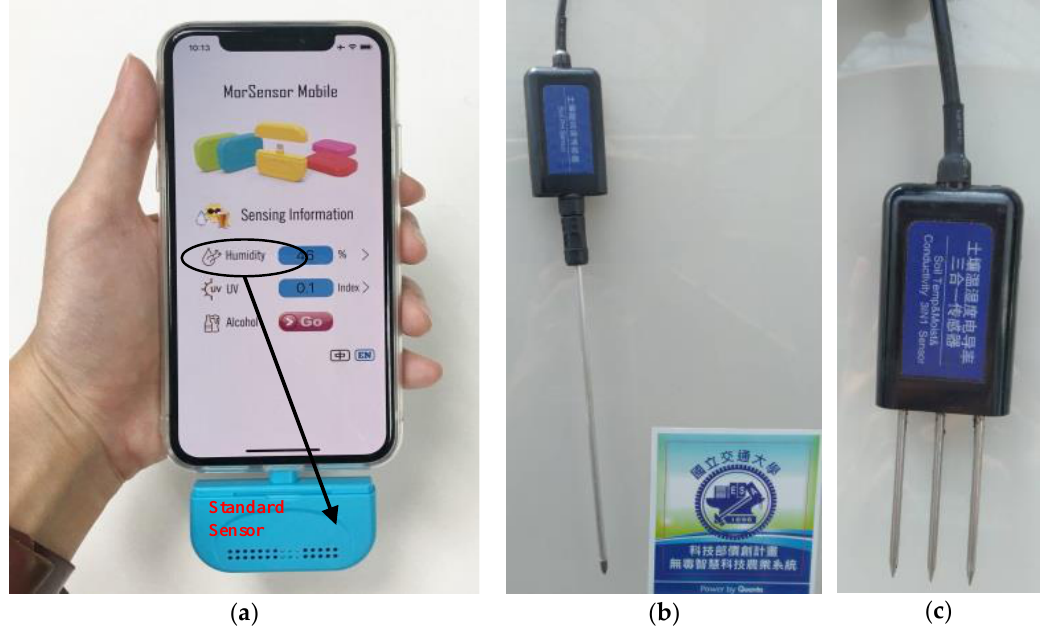
Figure 15. Smartphone-based portable STD value generator; ( a ) STD sensors in the air; ( b ) and ( c ) STD sensors in the soil. Table 1. Calibration mappings for a temperature sensor in the Bao farm.